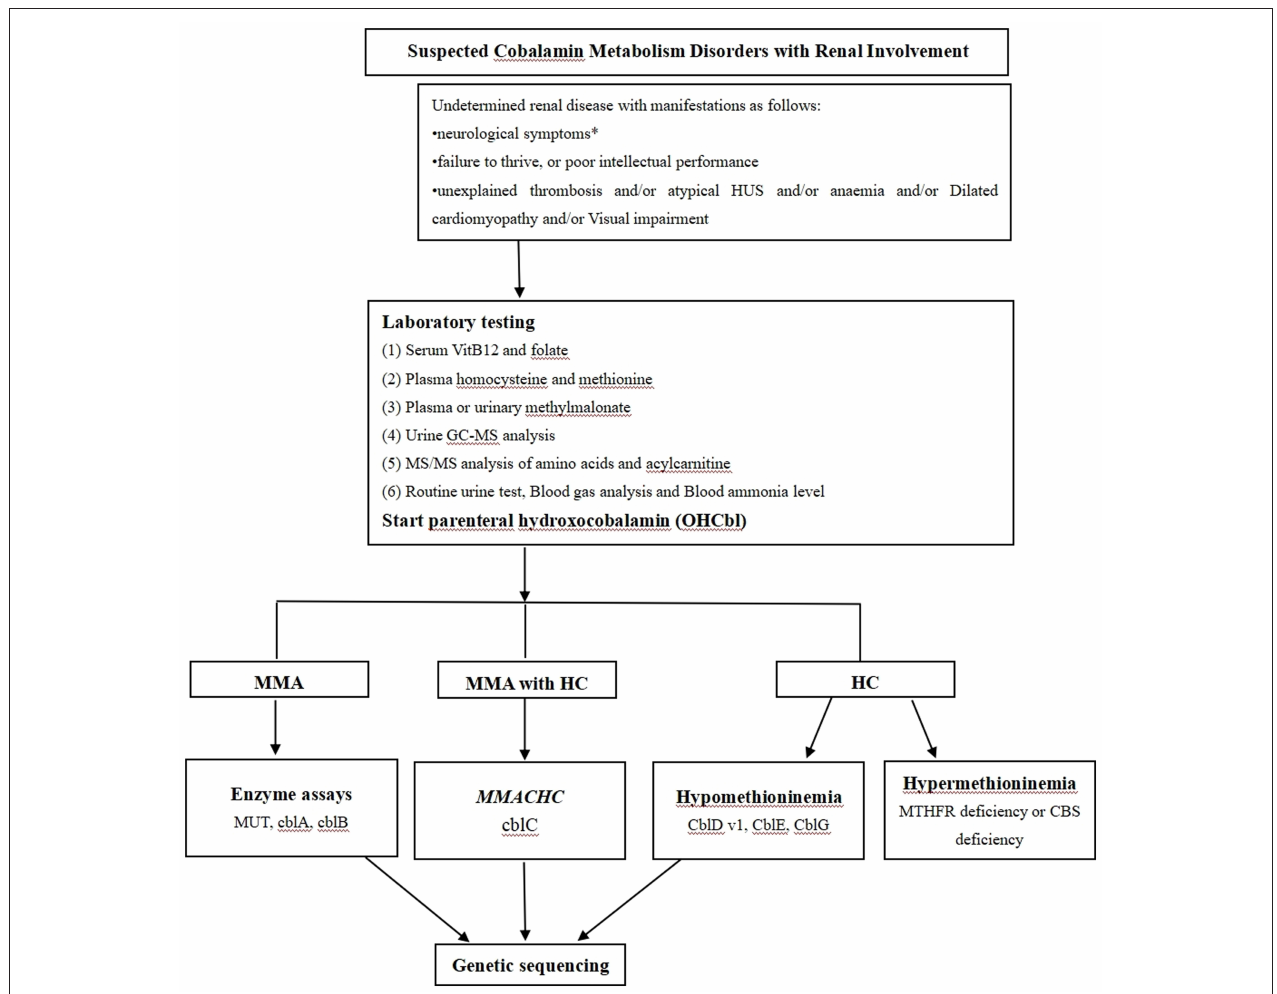
FIGURE 4 | The proposed diagnostic algorithm for suspected cobalamin metabolism disorders with renal involvement. Based on biochemical, enzymatic and genetic complementation analysis, several classes of cobalamin metabolism disorders are known as follows: mut0 /mut- type, cblA type, cblB type, cblC type, cblD-Var1 type, cblD-Var2 type, cblD type, cblF type, cblE type, cblG type, cblJ type, and cblX type; HUS: Hemolytic uremic syndrome; HC: Hyperhomocysteinaemia; MUT: Methylmalonyl-CoA mutase; MMACHC: Gene responsible for methylmalonic acidemia and homocystinuria, cblC type; MTHFR: Methylenetetrahydrofolate